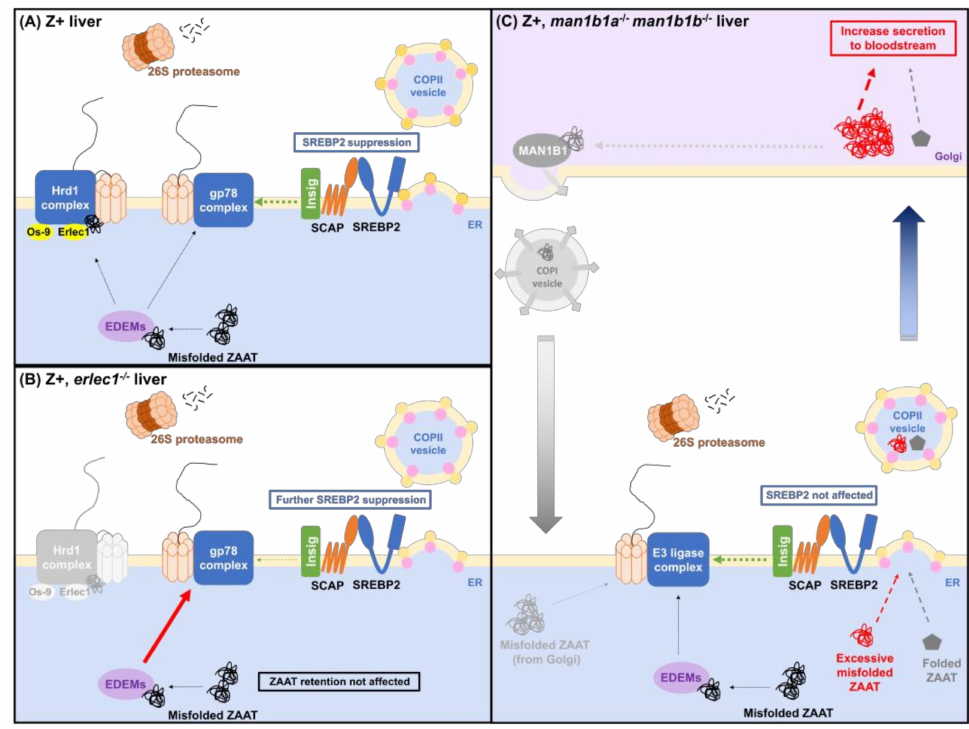
Figure 8. Model for ERAD pathway interference between the ZAAT processing system and cholesterol biosynthesis. ( A ) In zebrafish expressing ZAAT, degradation of misfolded ZAAT via ERAD-L limits the ERAD machinery available for Insig turnover via ERAD-M. More Insig, therefore, remains bound to the Scap-Srebp2 complex in the ER membrane, reducing Srebp2 release from the ER and suppressing activation of the downstream cholesterol biosynthesis pathway. ( B ) Ablation of Erlec1 prevents the retrotranslocation of misfolded ZAAT via the Hrd1 ligase complex and redirects it to the gp78 complex, further reducing the capacity for Insig degradation and enhancing Srebp2 retention in the ER membrane. ( C ) The absence of Man1b1 proteins in zebrafish liver enhances ZAAT secretion, consistent with a role for Man1b1 in the Golgi in retrieving misfolded ZAAT that escaped the ERQC system and returning it to the